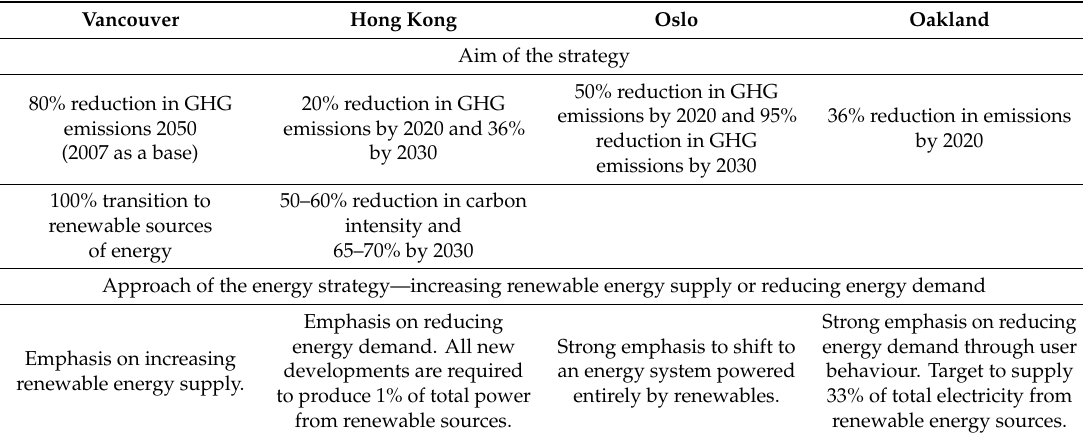
Table 2. Overall aims and approaches of the four